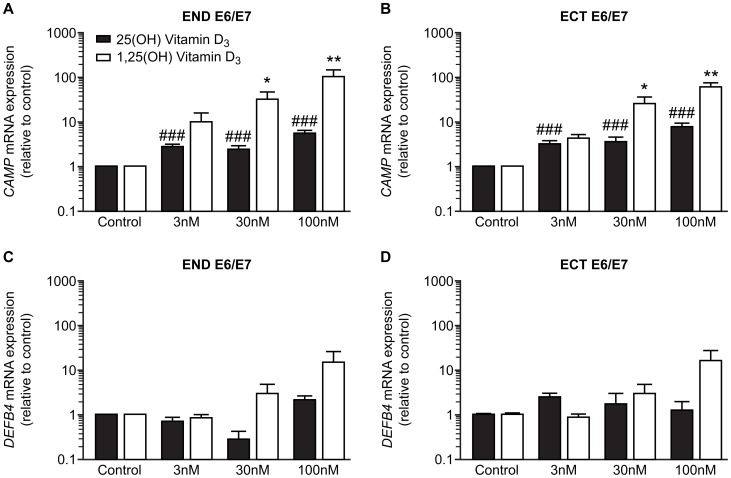
Effect of vitamin D on CAMP and DEFB4 expression in endocervical (END E6/E7) and ectocervical (ECT E6/E7) cell lines.Cells treated for 24(control), 3 nM, 30 nM or 100 nM of 25(OH) vitamin D3 or 1,25 (OH) vitamin D3. (A) END E6/E7 CAMP expression (n = 3), (B) ECT E6/E7 CAMP expression (n = 3), (C) END E6/E7 DEFB4 expression (n = 3), (D) ECT E6/E7 DEFB4 expression (n = 3). Data presented as mean fold change relative to control ± SEM. ##, ###, p<0.01, 0.001 respectively compared to 25 (OH) vitamin D3 control. *, **, p<0.05, 0.01 compared to 1,25(OH) vitamin D control3. (One-way ANOVA with Dunnett's post-test).